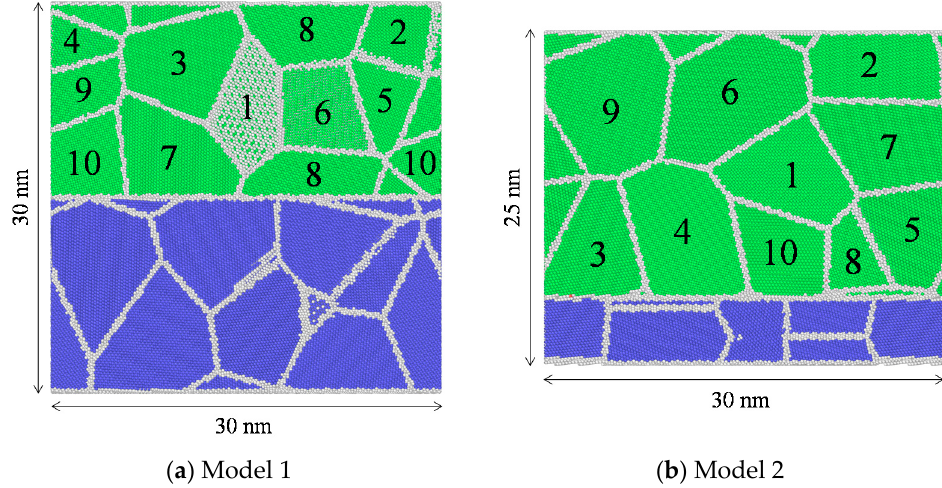
Figure 13. Two types of interfacial models for fatigue fracture. Table 3. Maximum Schmidt factor (MSF) in each grain and slip system, which takes the MSF in Model 1 ( a ) and Model 2 ( b ). MSFs with large absolute values are shown in red letters ( a )